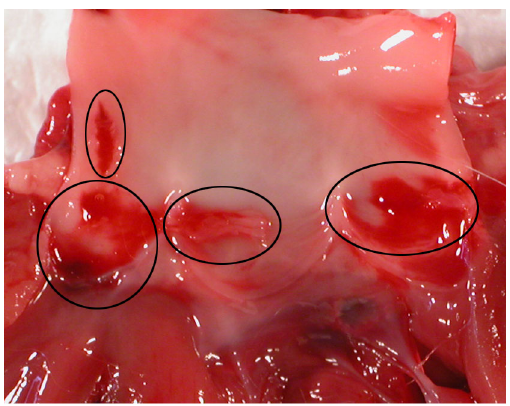
Figure 1. Enterococcusfaecalis OG1SSp (pINY1801, AS + ) infec- tious endocarditis aortic valve and aortic vegetations. Vegeta- tions are circled.